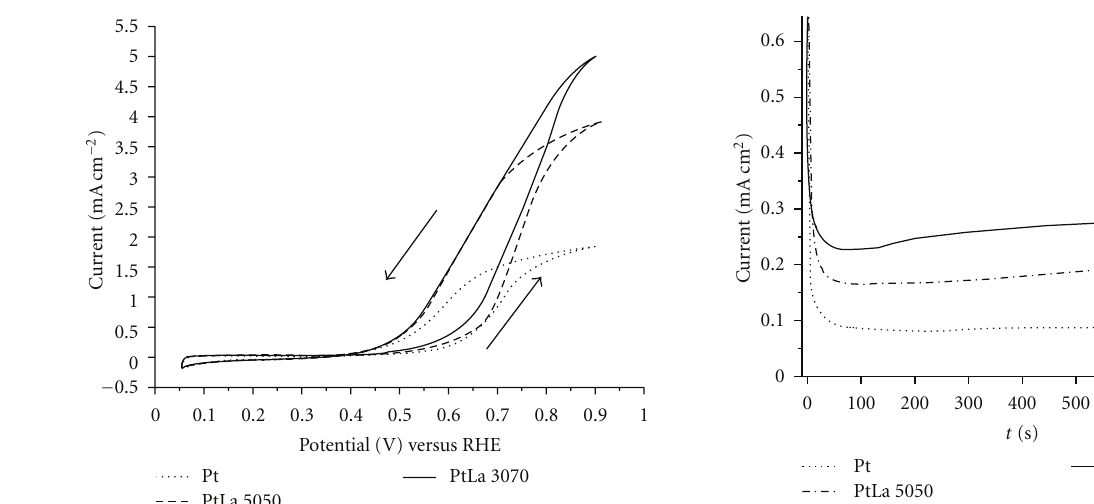
Figure 1: Cyclic voltammograms for ethanol electrooxidation on Pt/C, PtLa/C (50 :50), and PtLa/C (30:70) electrocatalysts in 1.0molL − 1 CH 3 CH 2 OH + 0.5 molL − 1 H 2 SO 4 in the 0.05 to 0.90 V potential range at room temperature. Scan rate: 0.010 Vs − 1 .